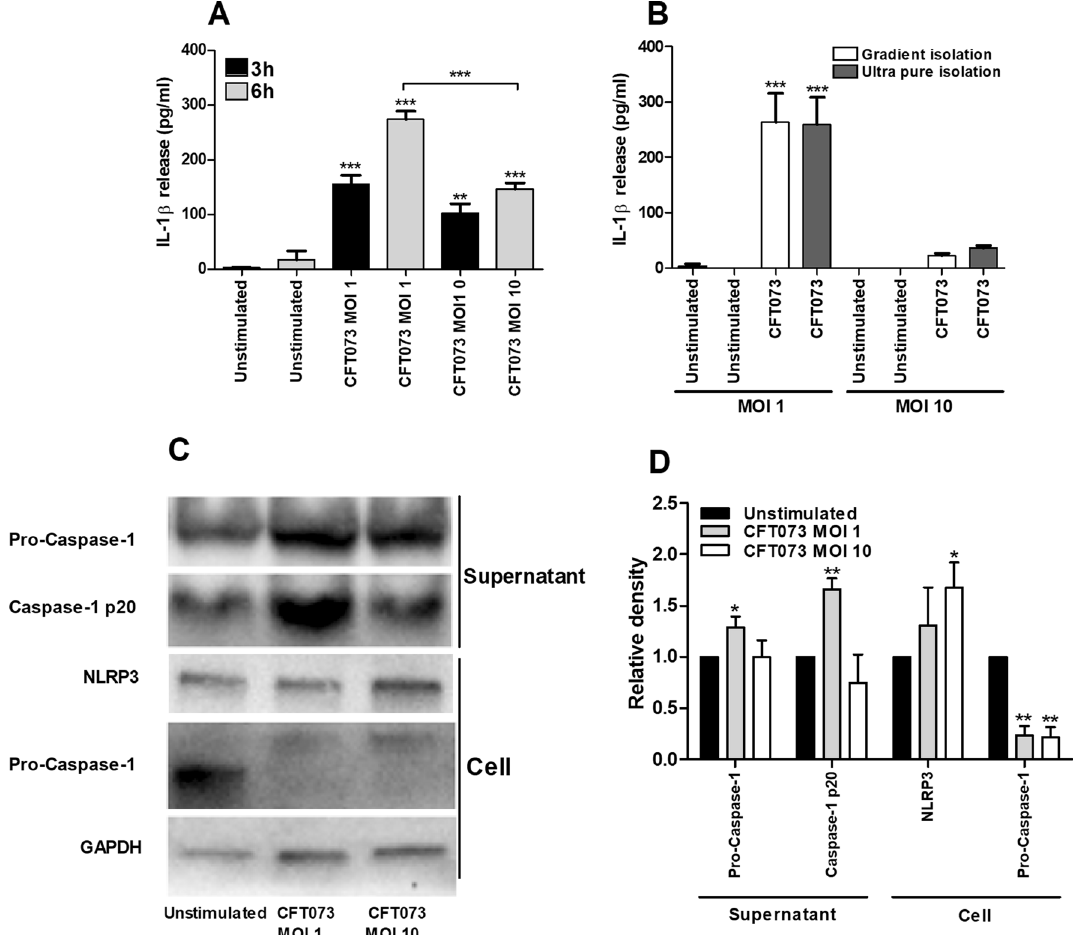
.Figure 2. IL-1β release and protein expression of caspase-1 and NLRP3. Neutrophils were infected with UPEC strain CFT073 at MOI 1 or MOI 10 for 3 h ( A ) and 6 h ( A – D ) followed by analysis of IL-1β release ( A , B ) and caspase-1 and NLRP3 protein expression by Western blot analysis ( C , D ). GAPDH was used as a loading control and to normalize the quantification of the Western blots. Original western blot presented is available in Supplemental Fig. S1. Data are presented as mean ± SEM (n = 3 independent experiments). Asterisks over bars denote statistical significance compared to respective unstimulated control (*p < 0.05, **p < 0.01, ***p <